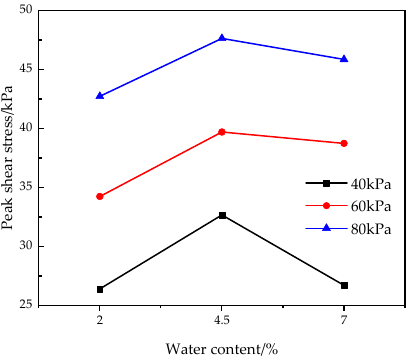
Figure 9. The relationship curve between the shear strength and normal stress of the reinforced soil interface under a nonfreezing state (0 °C).